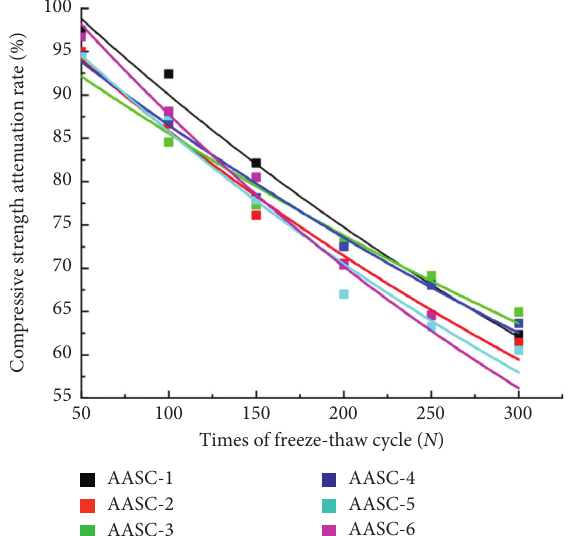
Figure 12: Compressive strength attenuation exponential function